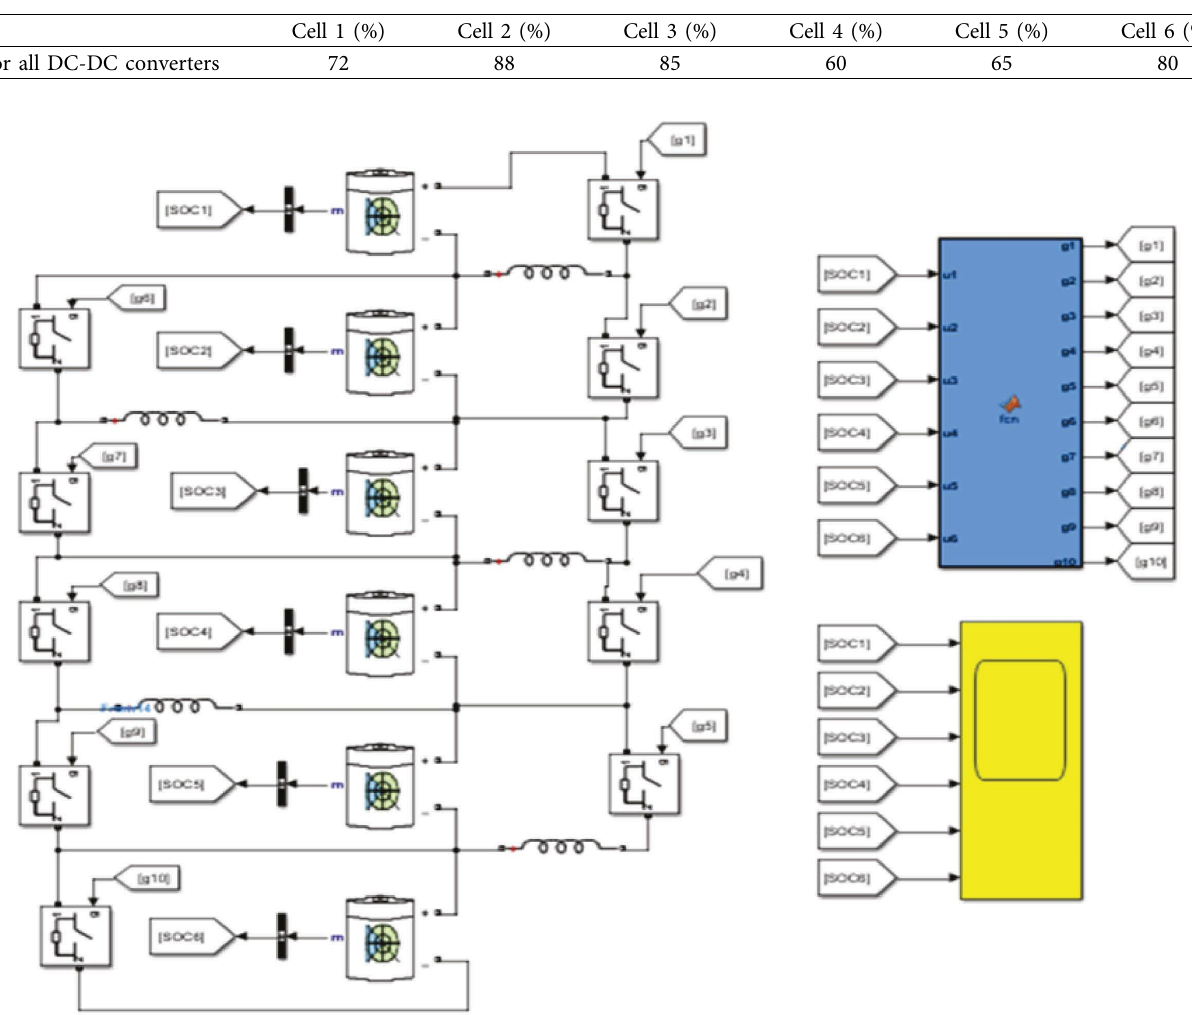
Table 9: Initial SOC values of diferent cells.